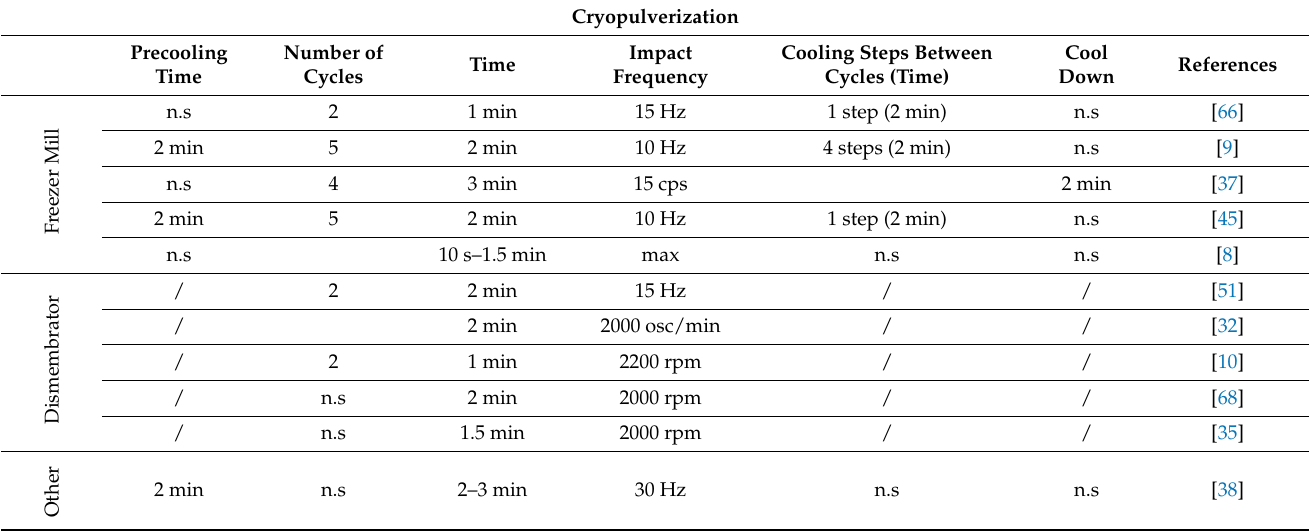
Table 3. Cryopulverization protocols and related